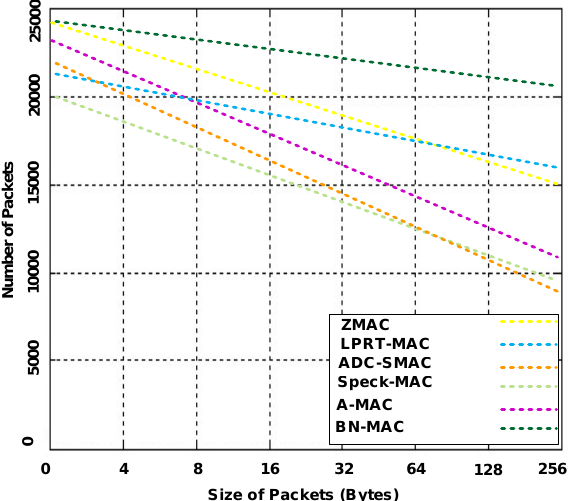
Figure 19. Number of packets delivered with variable packet